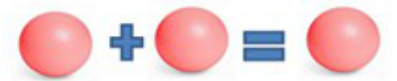
Figure 1. Operaton in a unitary group, ball + ball =